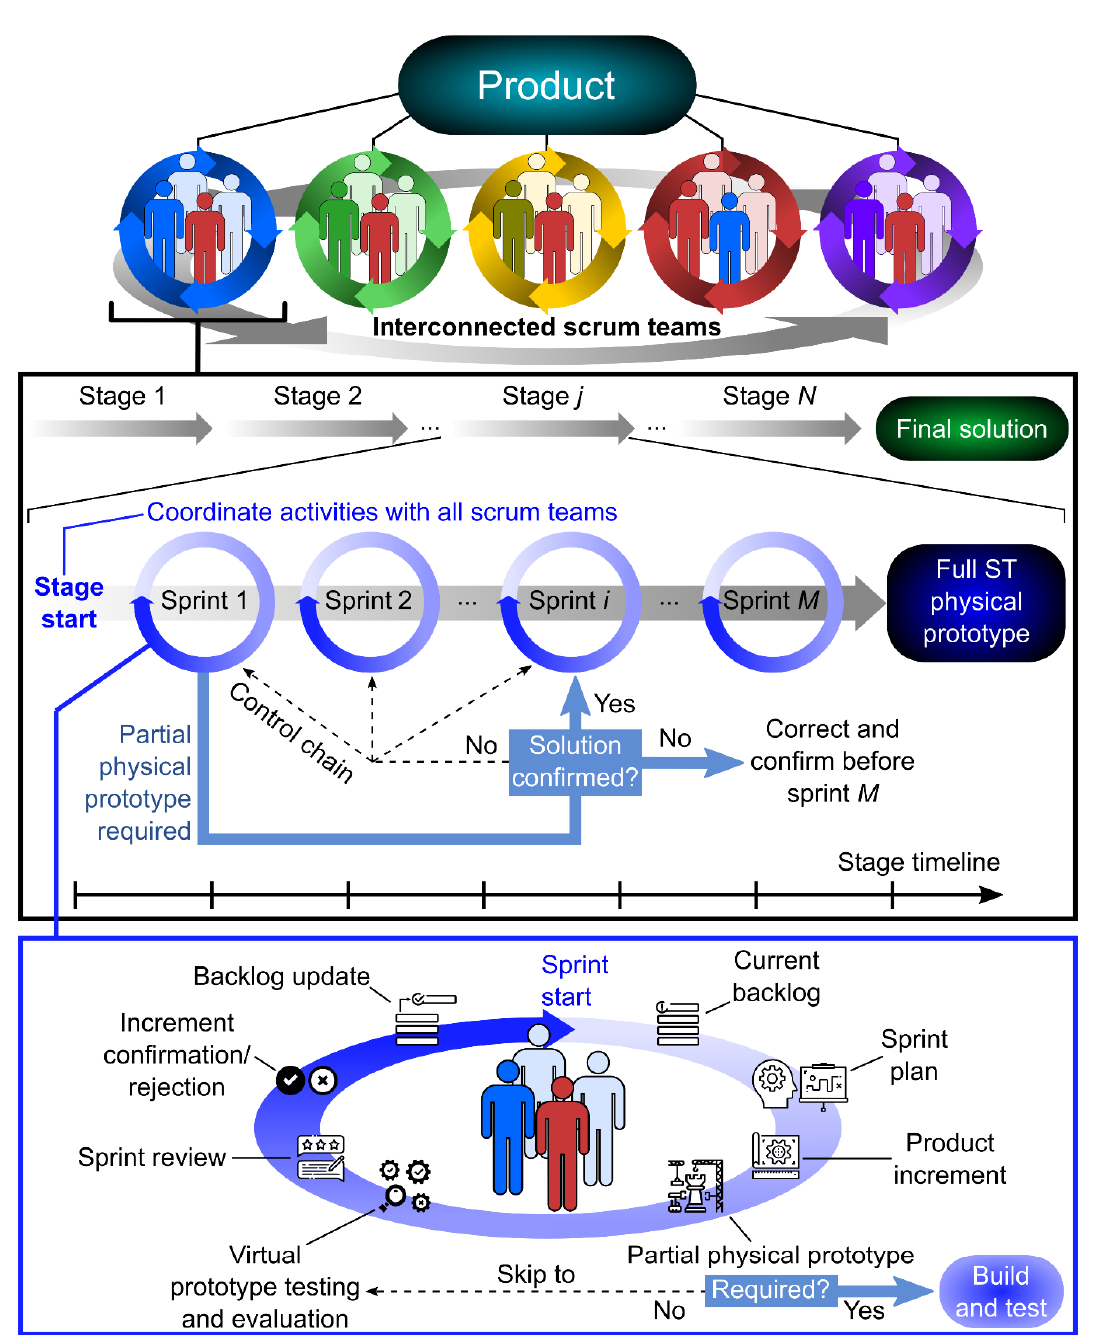
Figure 11. Scrum team workflow based on the Agile product development process.